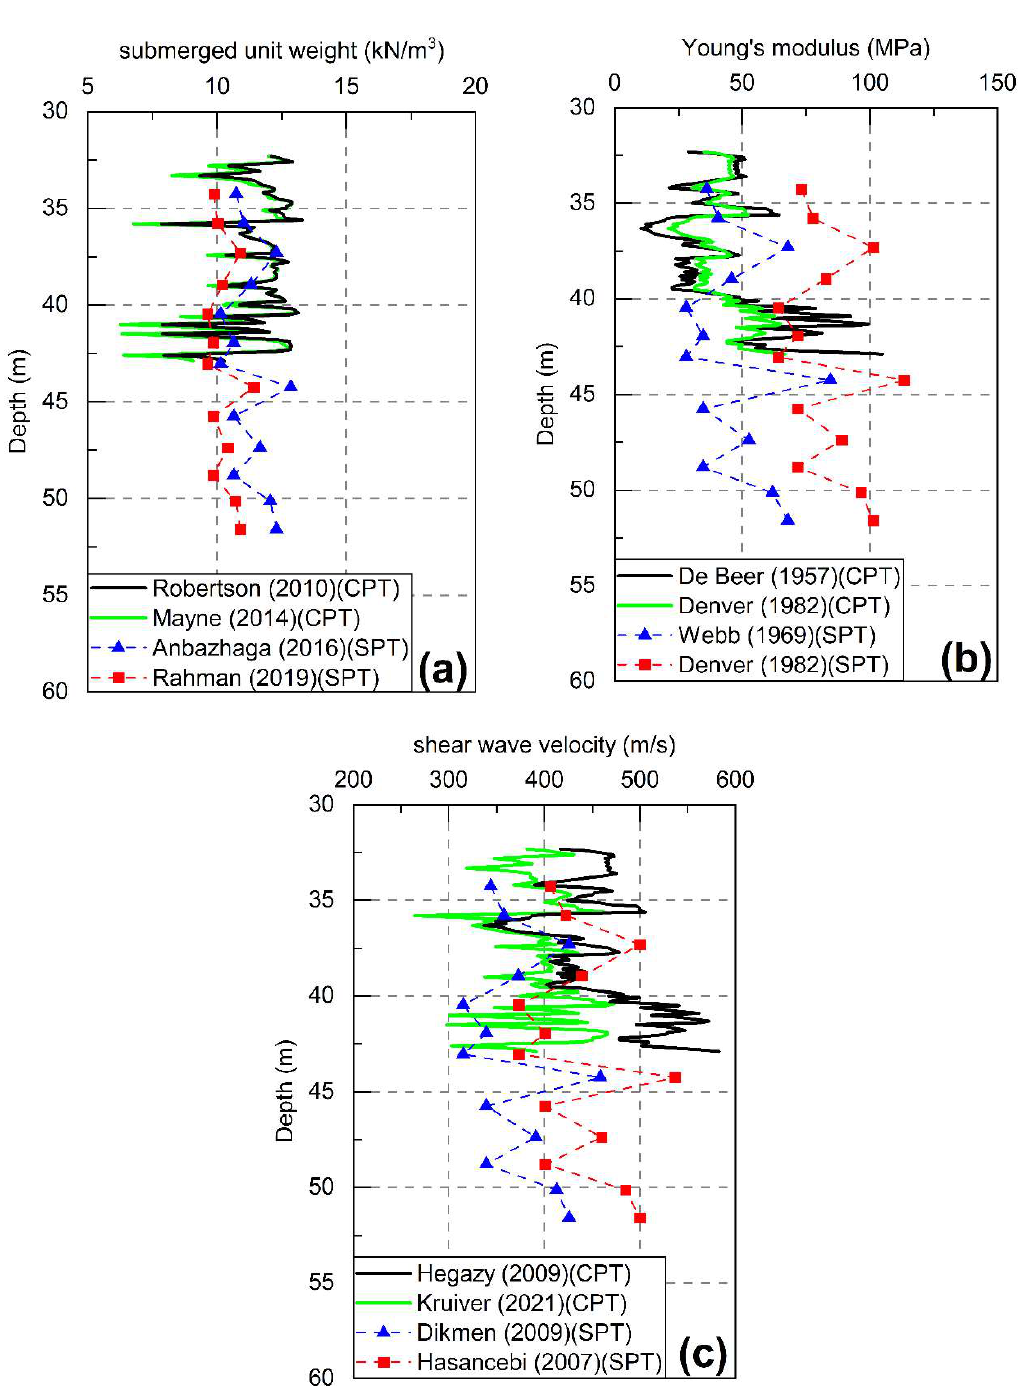
Figure 6. SPT- and CPT-based engineering properties of a gneiss layer [27–37]: ( a ) submerged unit weight; ( b ) Young’s modulus; ( c ) shear wave velocity. weight; ( b ) Young’s modulus; ( c ) shear wave